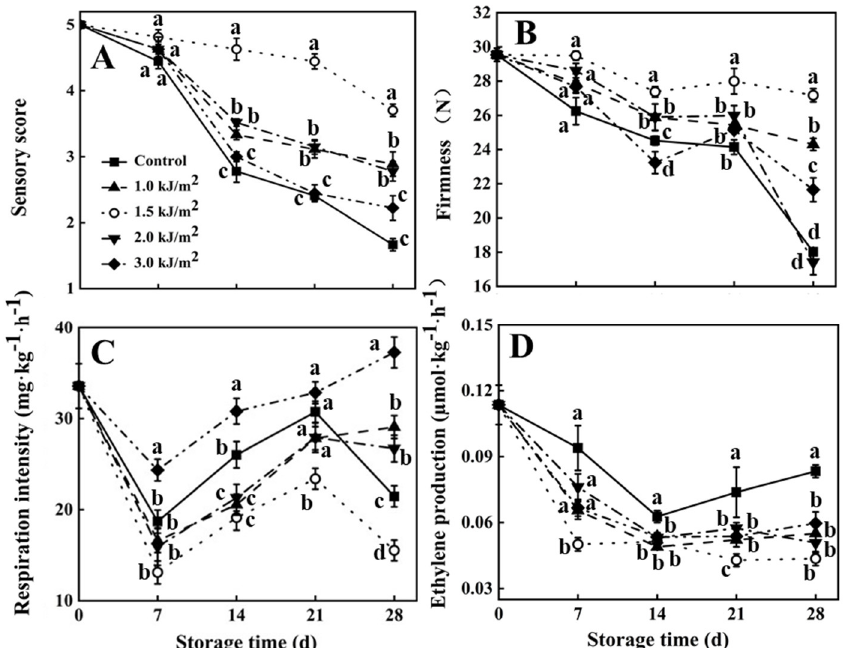
Figure 1. Sensory score ( A ), firmness ( B ), respiration rate ( C ), and ethylene production ( D ) of pepino fruit treated with different UV-C dose during storage. Data represent the mean ± SE ( n = 3). Different letters indicate significant differences ( p < 0.05) between sample groups at the time of sampling.